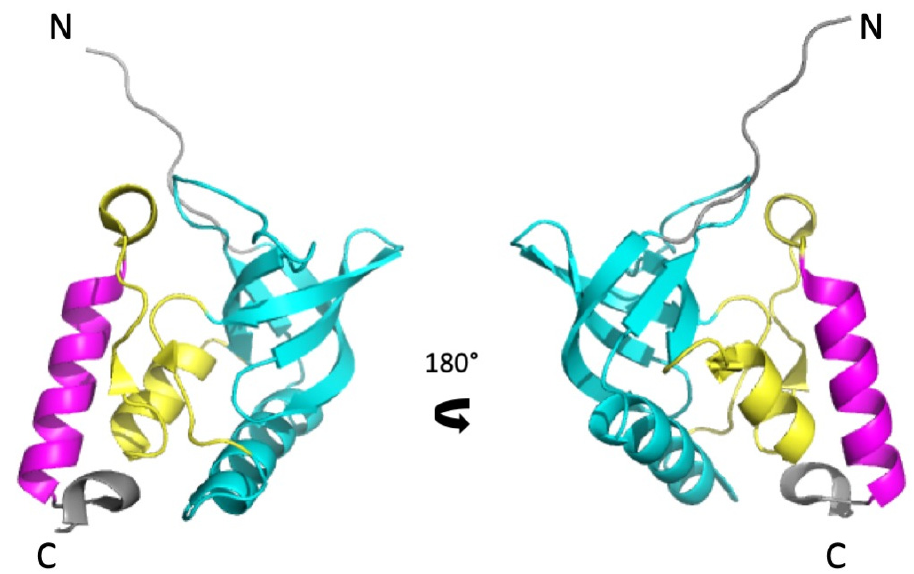
Figure 1. The subdomain organization of the structure of Staphylococcal Nuclease (PDB ID: 3LX0) . Two views (180° rotation along the vertical axis) of a cartoon representation of the 3D structure of ∆ +PHS Staphylococcal Nuclease. SubD1, IntD, and SubD2 subdomains are colored in cyan, yellow, and magenta, respectively.